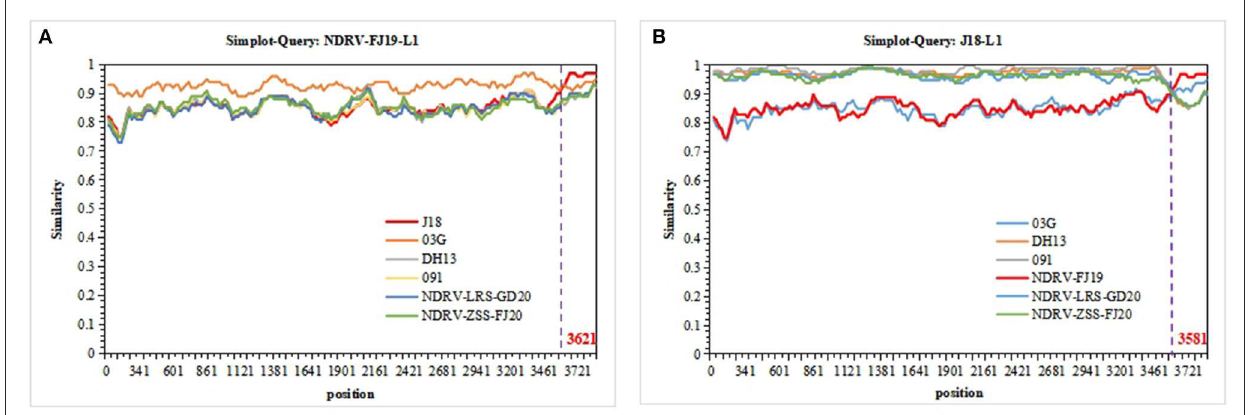
FIGURE5 Recombination analyses of the segment sequences of three strains. NDRVs and others were screened using RDP4 and visualized using SimPlot 3.5.1. (A) Recombination analysis of the L1 segments of NDRV-FJ19. (B) Recombination analysis of the L1 segment of J18.